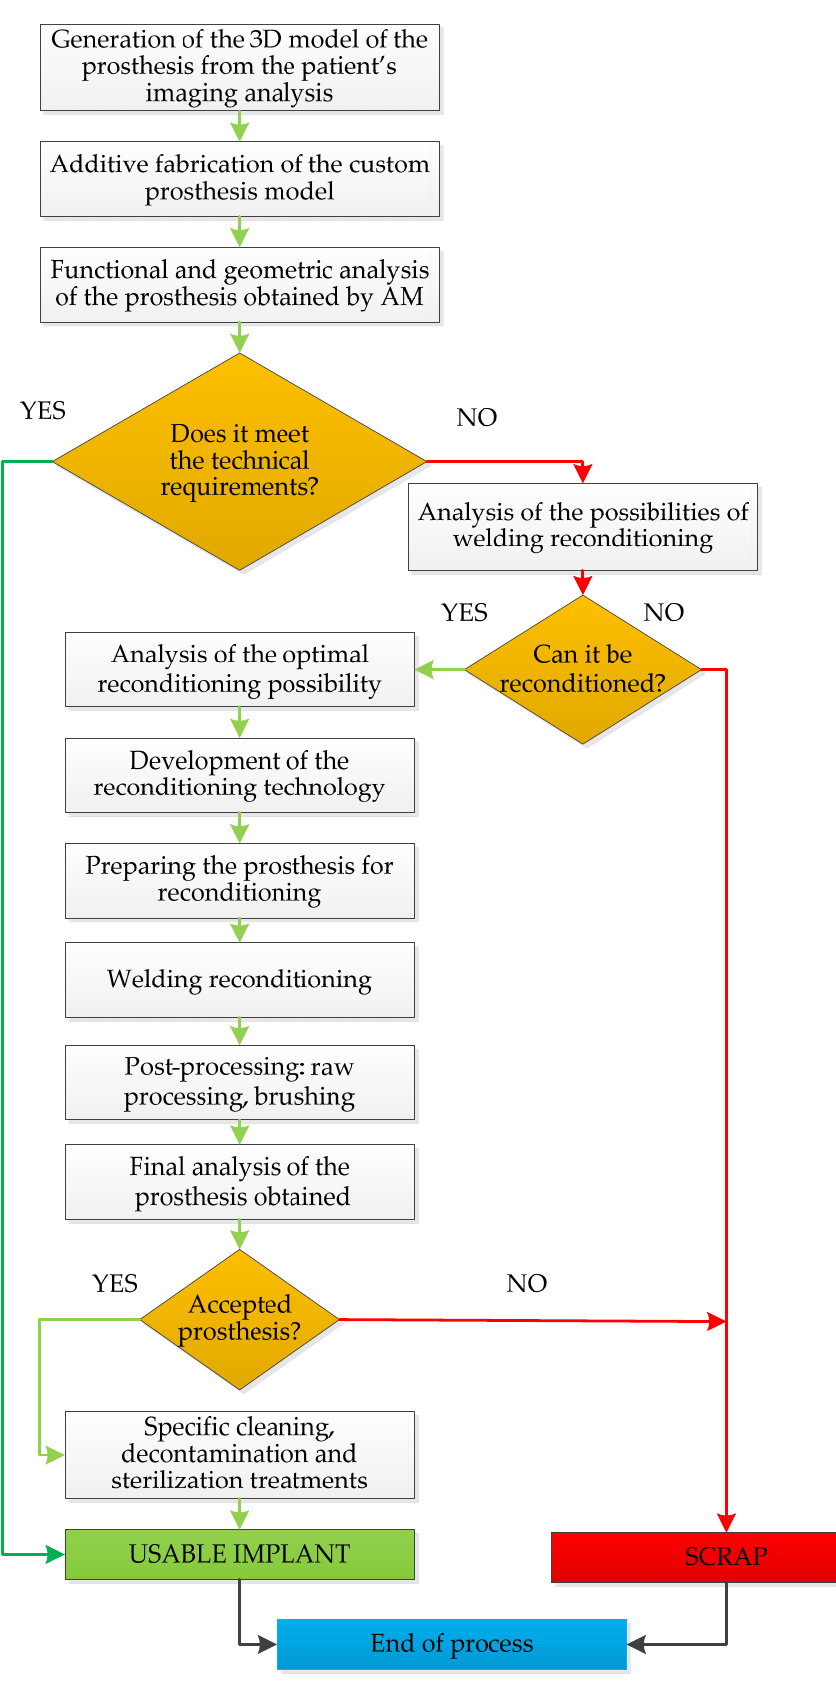
Figure 4. Welding reconditioning flowchart for customized implants.